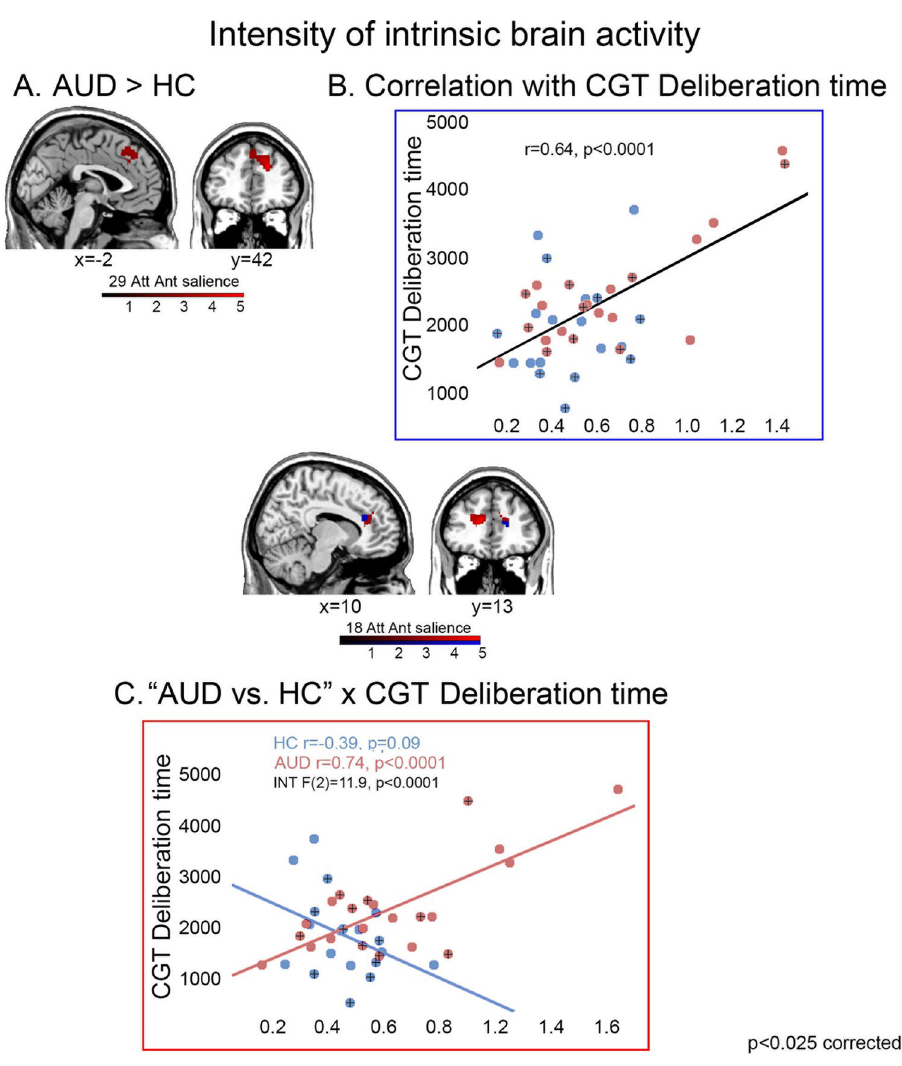
Figure 3. Intensity of intrinsic brain activity: group comparison and latency-by-group interaction. The figure depicts the resting-state components in which intrinsic activity was significantly stronger in AUD patients than controls (29; panel A ), those showing a significant correlation between intensity of activation and decision latency regardless of group (blue color in component 18; panel B ), and those displaying a significantly different relationship between intensity of activation and decision latency in AUD patients vs. controls (red color in component 18; panel C ) (p < 0.025 corrected). Colour bars denote the direction and strength of these effects. In the scatterplots, a “plus” +) sign denotes female participants. Att Ant salience anterior salience network; INT